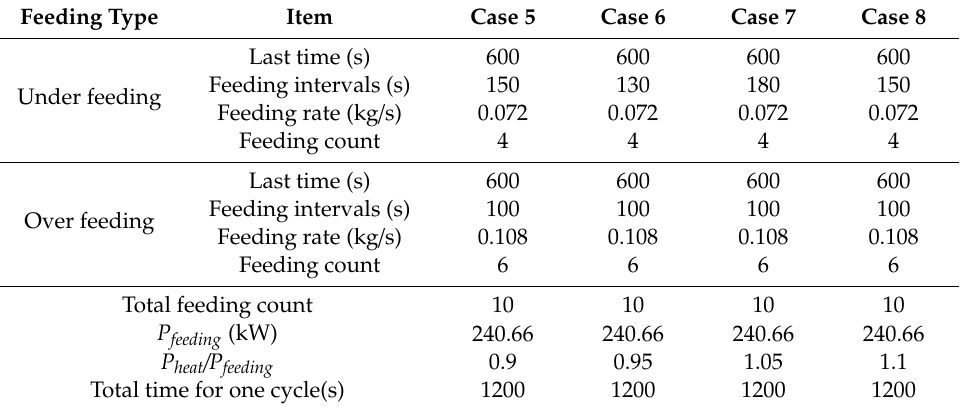
Table 3. Simulation conditions of di ff erent cases in the transient model (Cases 5–8)